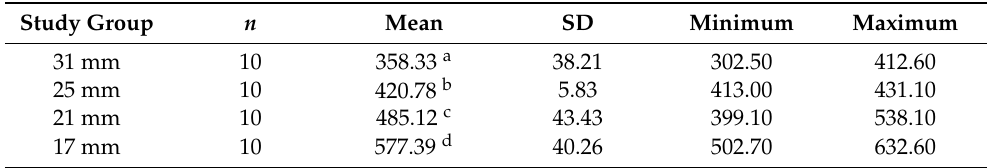
Table 1. Descriptive analysis of time to failure (seconds).